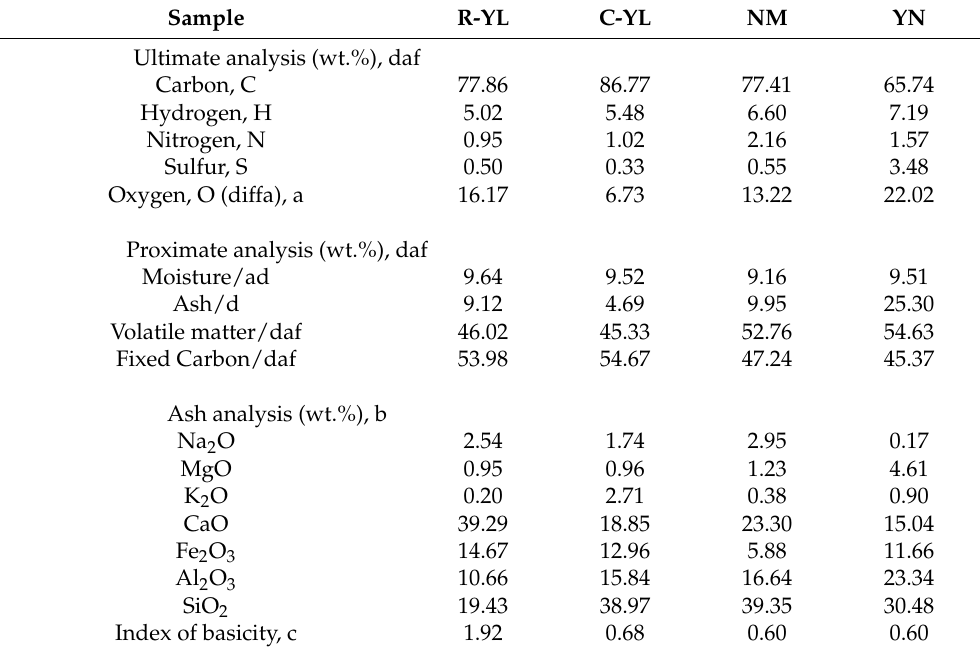
Table 1. Characteristics of four low-rank